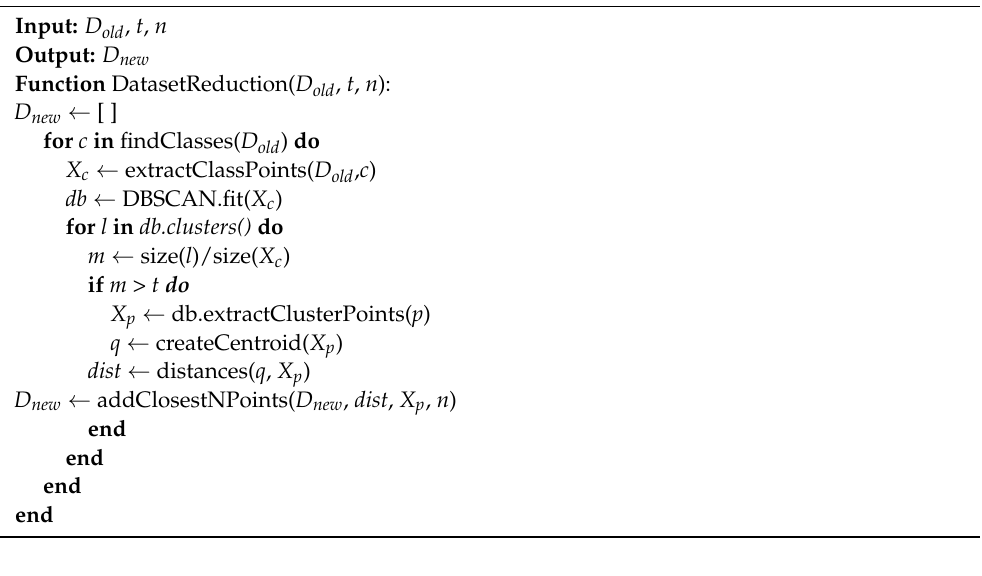
Algorithm 1: Dataset reduction using clustering.